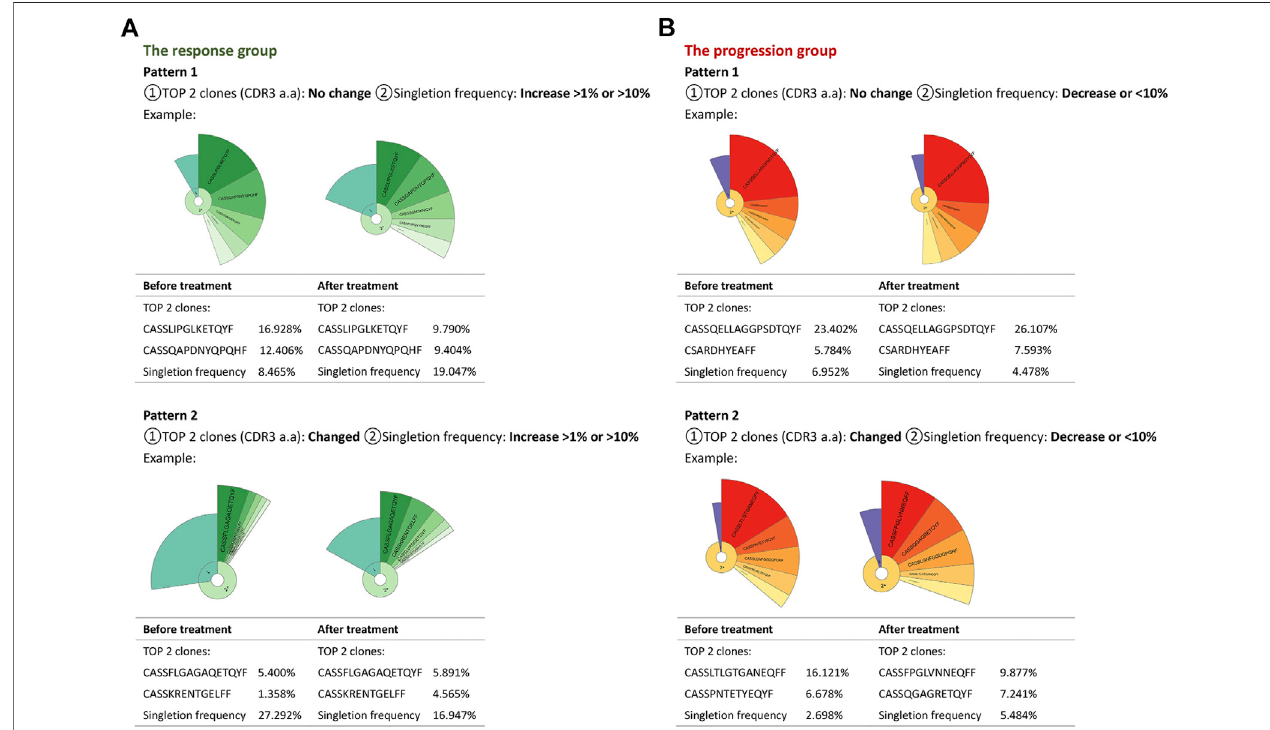
FIGURE 4 | Changing patterns of the TCR repertoire in the progression and response groups. Donut charts and tables summarized two patterns in each group. Each pattern took one patient as an example in either group. The fan-shaped area depicts the corresponding clonal frequency. The area of “ 1 ” in the donut chart represented the frequency of singletons. “ 2+ ” area was the TCR sequences whose reads were more than two. A larger radian meant a higher frequency. The top fi ve clones ’ amino acid sequences of complementary determination region 3 (CDR3) of TCR were shown, and the frequencies of the top two clones were listed. The radian marked with the amino acid sequence displayed the frequency of the corresponding T-cell clones.